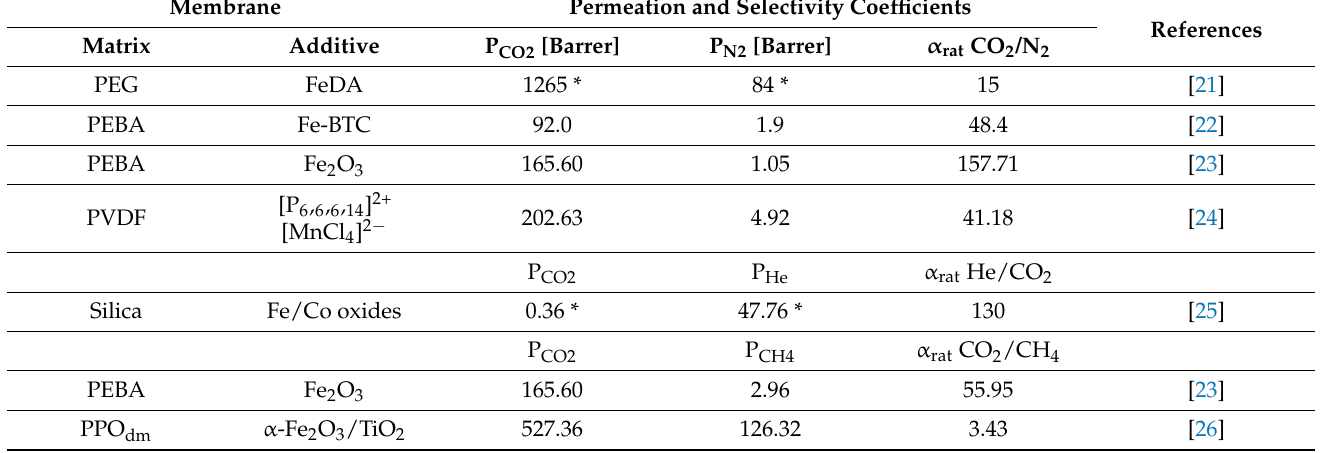
Table 2. Permeability (P) and selectivity coefficients ( α ) determined for the CO 2 /N 2 , He/CO 2 and CO 2 /CH 4